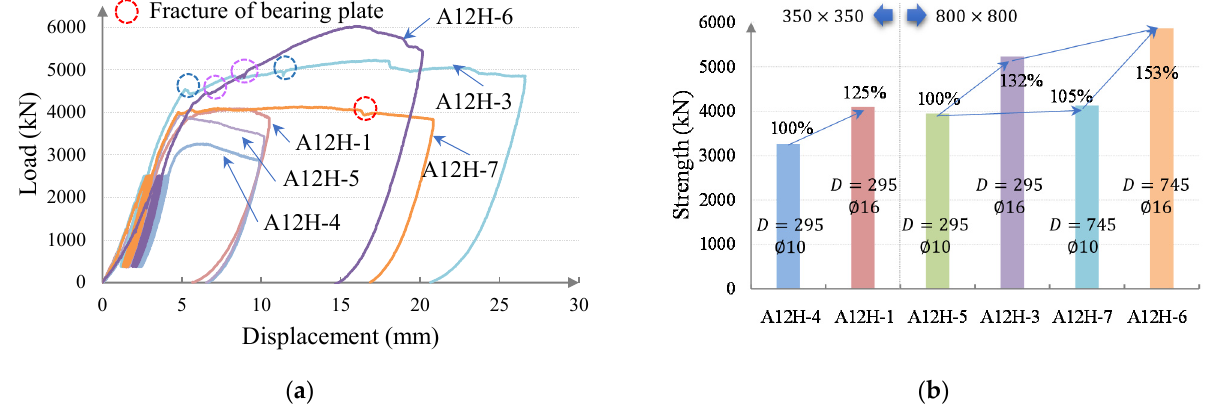
Figure 9. Test results of group 2 specimens: ( a ) load-displacement curve; ( b ) ultimate bearing strength.